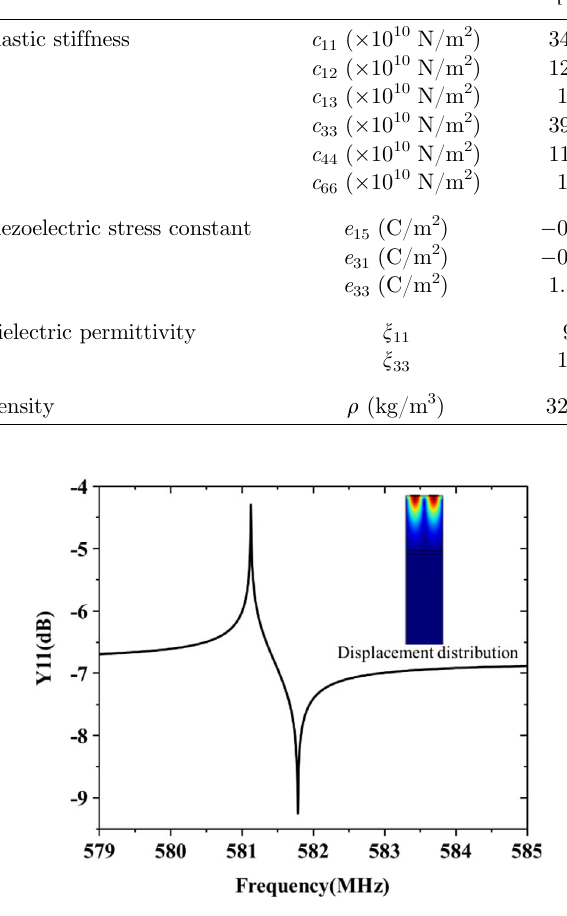
Figure 2. Calculated admittance amplitude (dB) curve.